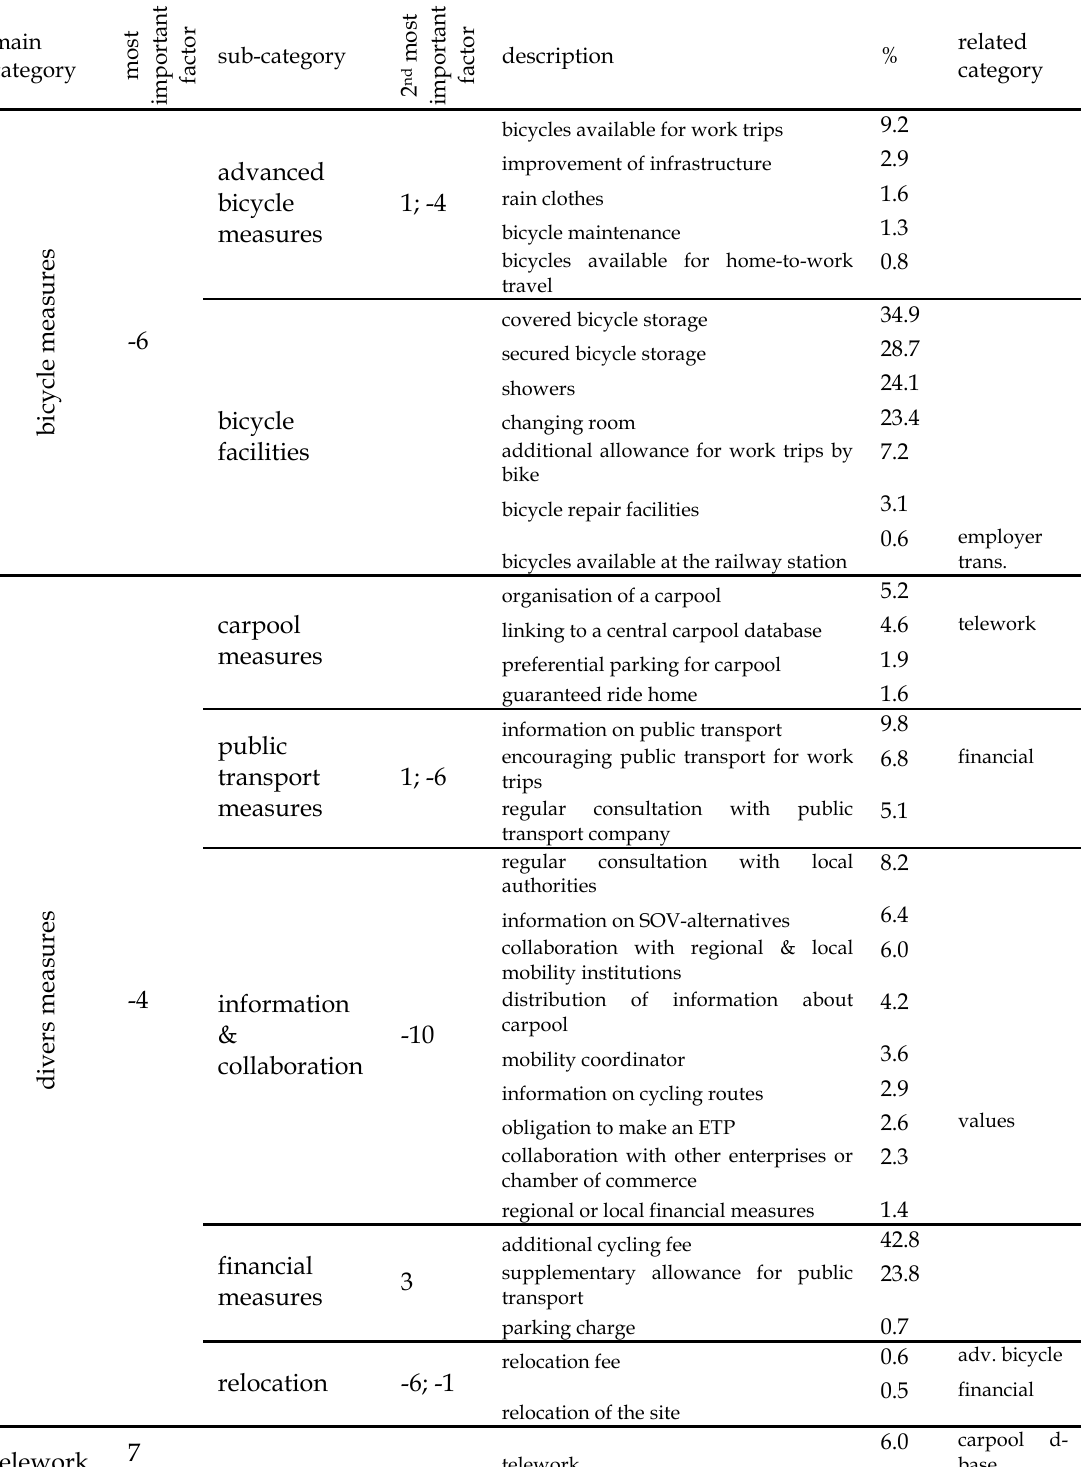
Table 3. Classification of mobility management